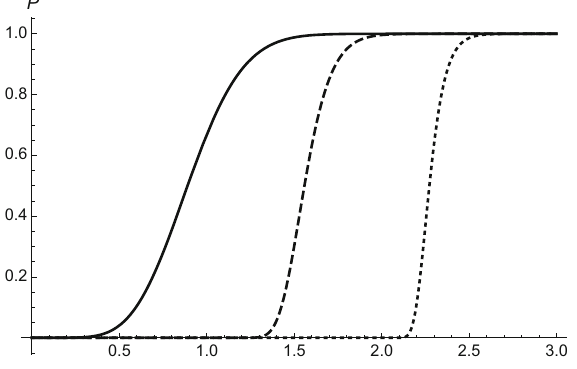
Fig. 4 Black hole probability (3.39) as a function of γ = (cid:7) ˆ R ( + ) (cid:6) ( solid line ) and (cid:7) ˆ R ( − ) (cid:6) ( dashed line ) in H H for N = 1 ( solid line ), N = 10 2 ( dashed line ) and N = 10 6 ( dotted line